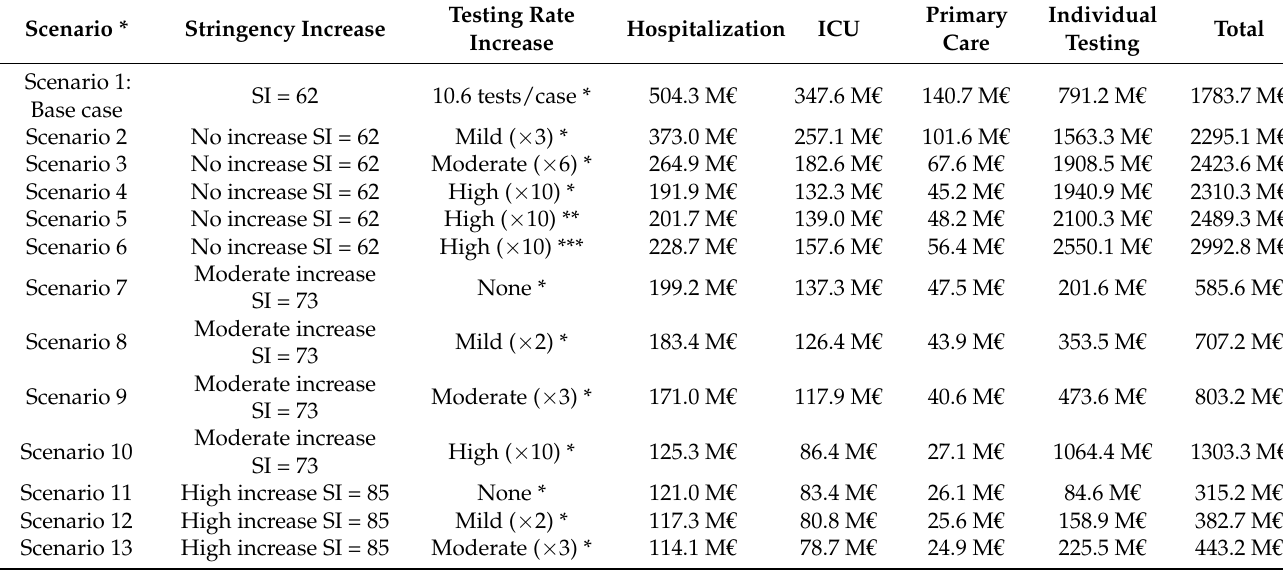
Table 2. Direct costs by type of cost for each scenario.